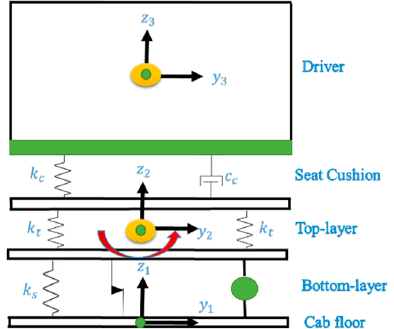
Figure 16. Schematic diagram of a two-layer multiple-degrees-of-freedom (multiple-DOF) seat suspension [53].